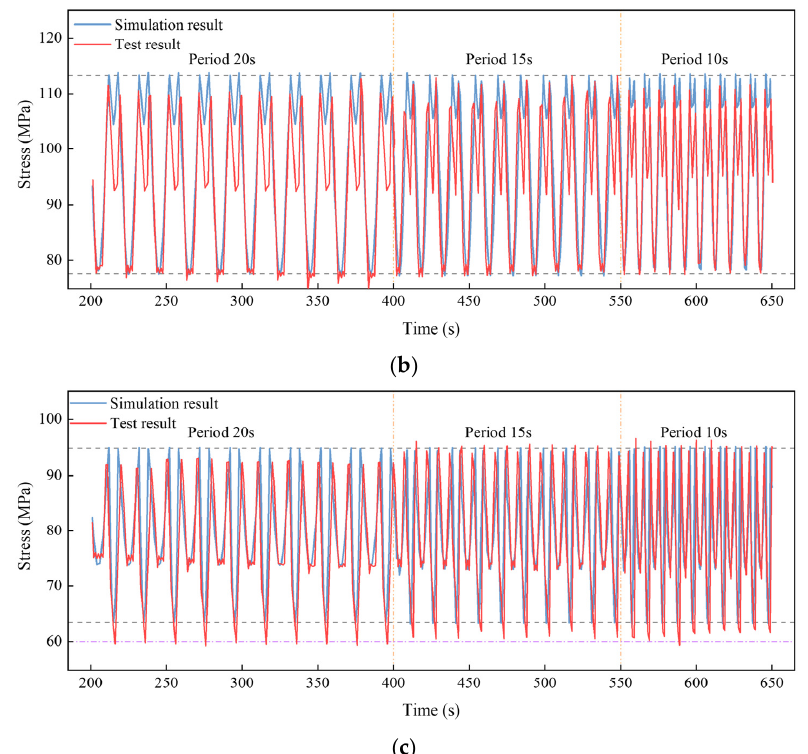
Figure 27. Time histories of the in-plane stress when the amplitude was 200 mm and the period decreased from 20 s to 10 s: ( a ) S2; ( b ) S5 and ( c ) S8.